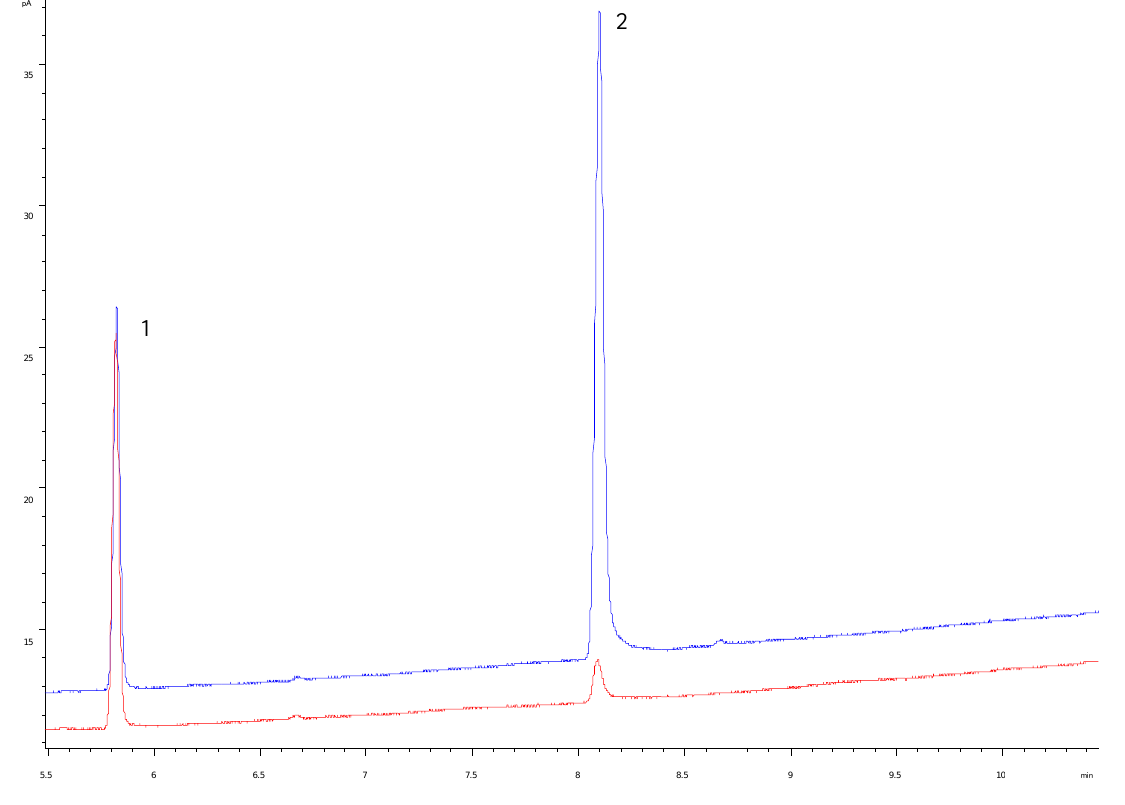
Figure 1. Cholesterol profile by gas chromatography with flame ionization detector in control cheese and experimental cheese with 1% of beta cyclodextrin. Peaks: 1 = 5 α -cholestane; 2 = cholesterol. Blue line: control cheese (CC); Red line: experimental cheese